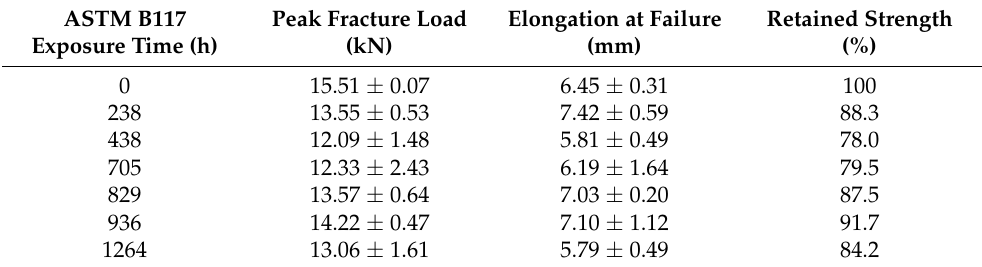
Table 4. Summary of lap shear tensile testing for three-step insulated bolted CFRC-AZ31B